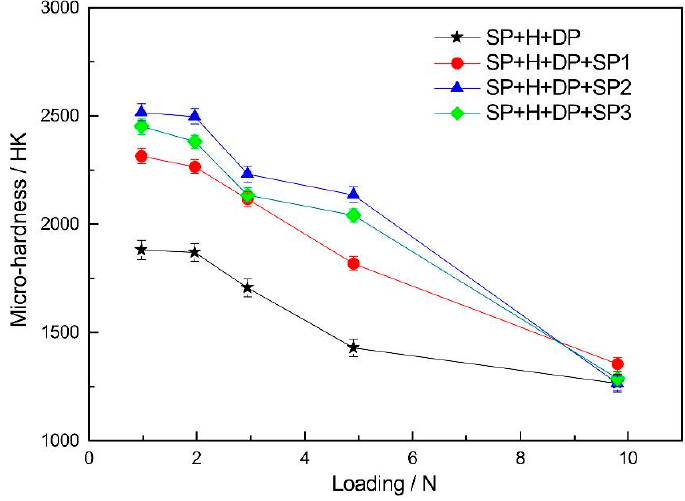
Figure 6. Surface hardness of coatings with different treatments along with loading changing.